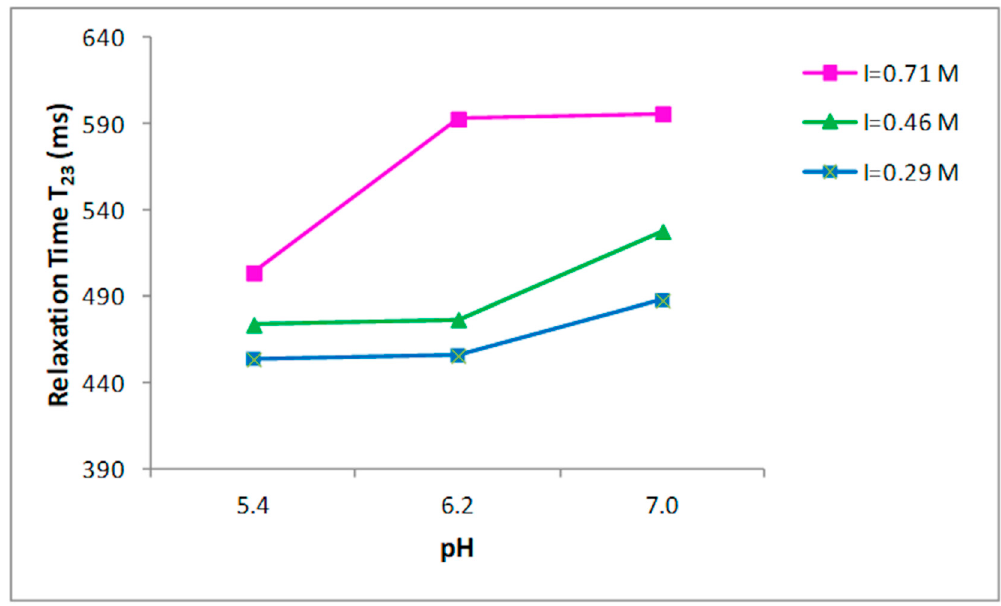
Figure 4. Relationship between the pH and T 23 relaxation time in collagen at different ionic strengths.